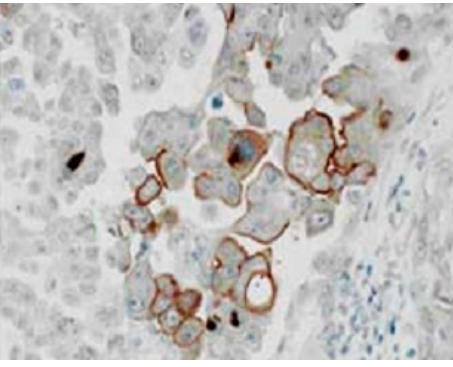
Figure 4. Immunohistologic finding of PEPT1 in peritoneal metastasis, using anti-PEPT1 rabbit polyclonal antibody H-235 (1:200 dilution; Santa Cruz Biotech, Santa Cruz, CA, USA). ABCG2 is known as an PpIX efflux transporter [14,15]. ABCG2 is expressed on the cell